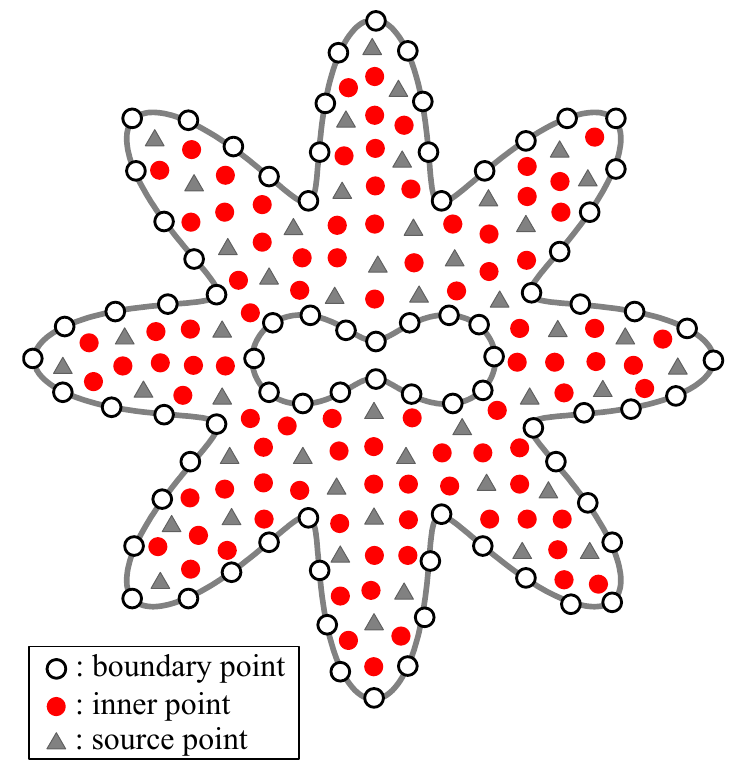
Figure 14. Layout of boundary, source and inner points.